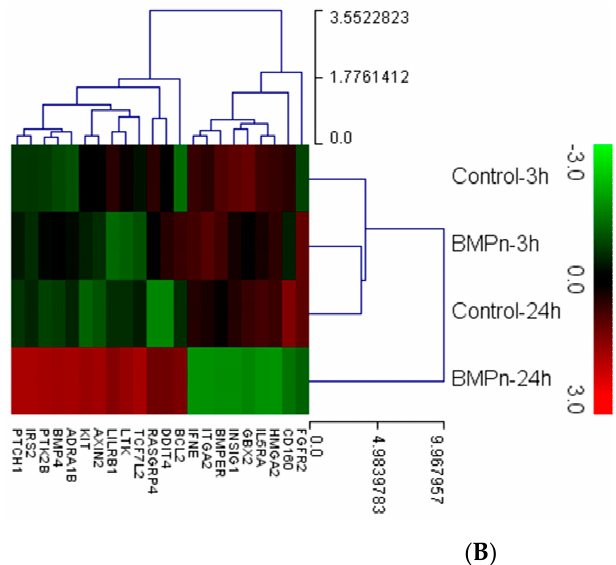
Figure 4. Clustering analysis of differentially expressed mRNA related to cell proliferation ( A ) BMP-7 at 24 h/control at 24 h and ( B ) BMP-7 at 24 h/BMP-7 at 3 h (fold change fold change of greater than 2, log2 normalized read counts >4 were selected).